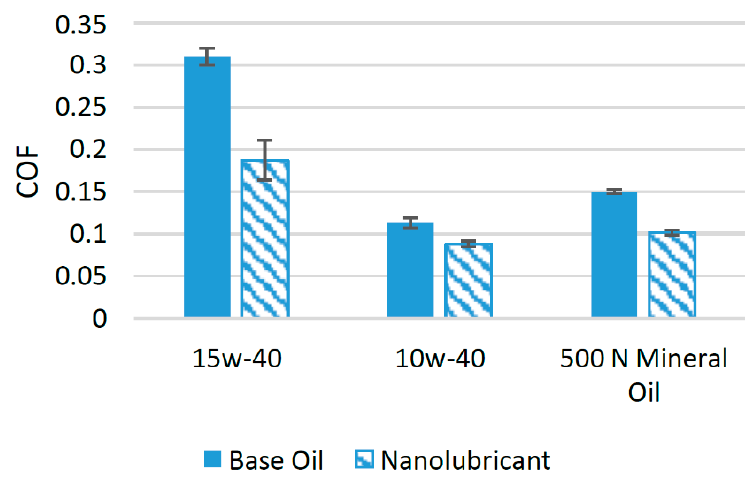
Figure 9. Effect of MWCNTs on the friction performance of synthetic lubricants.